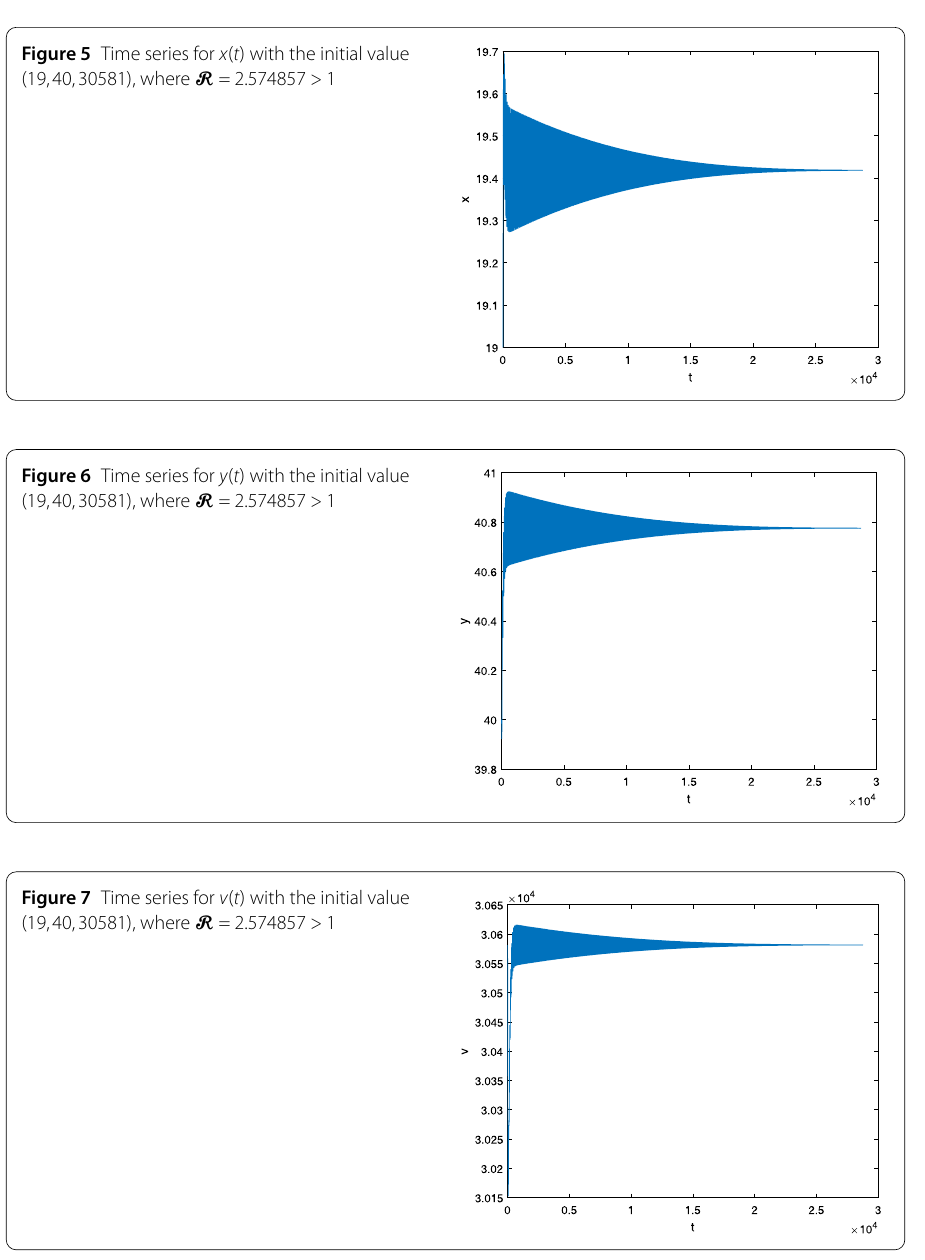
Figure 7 Time series for v ( t ) with the initial value (19,40,30581), where R = 2.574857 >